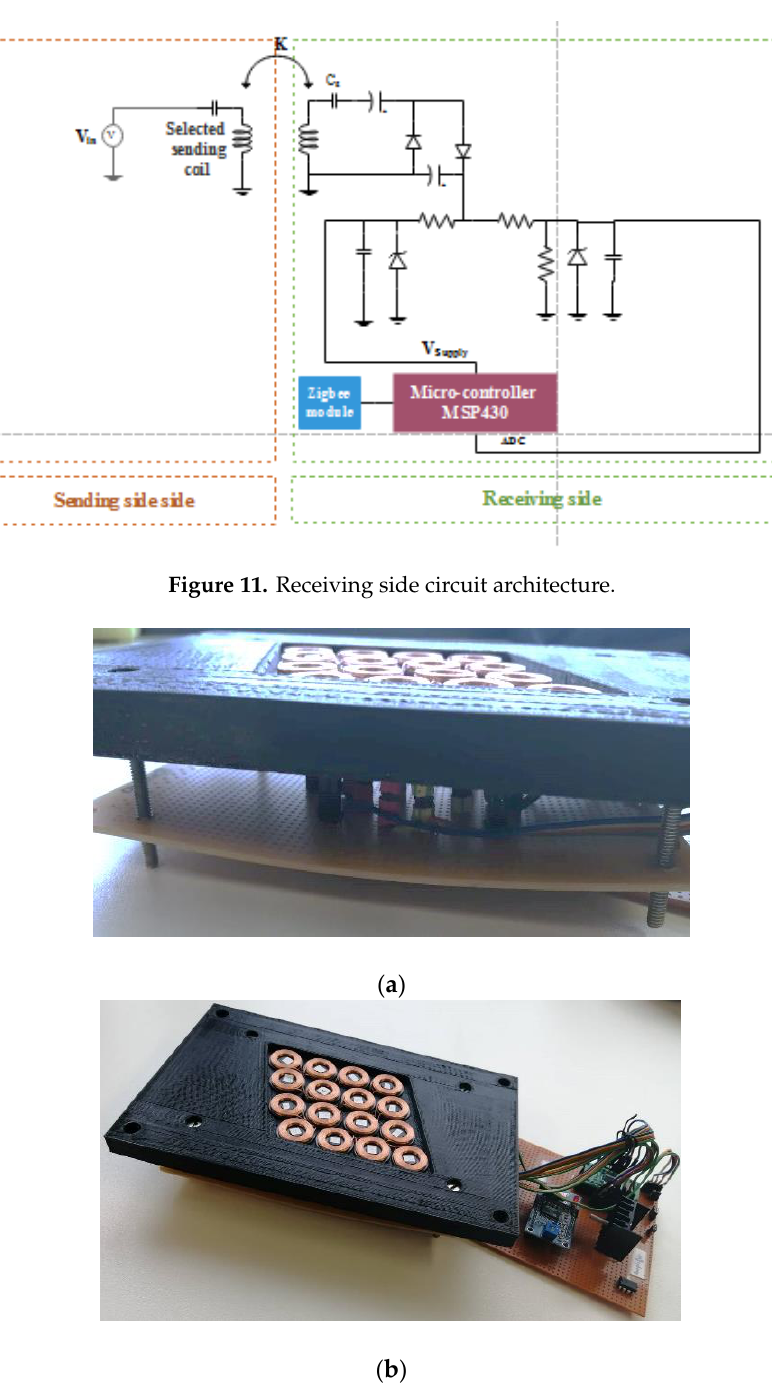
Figure 12. Real setup of the proposed primary side of the MISO-WPT system ( a ) First and second layers ( b ) All